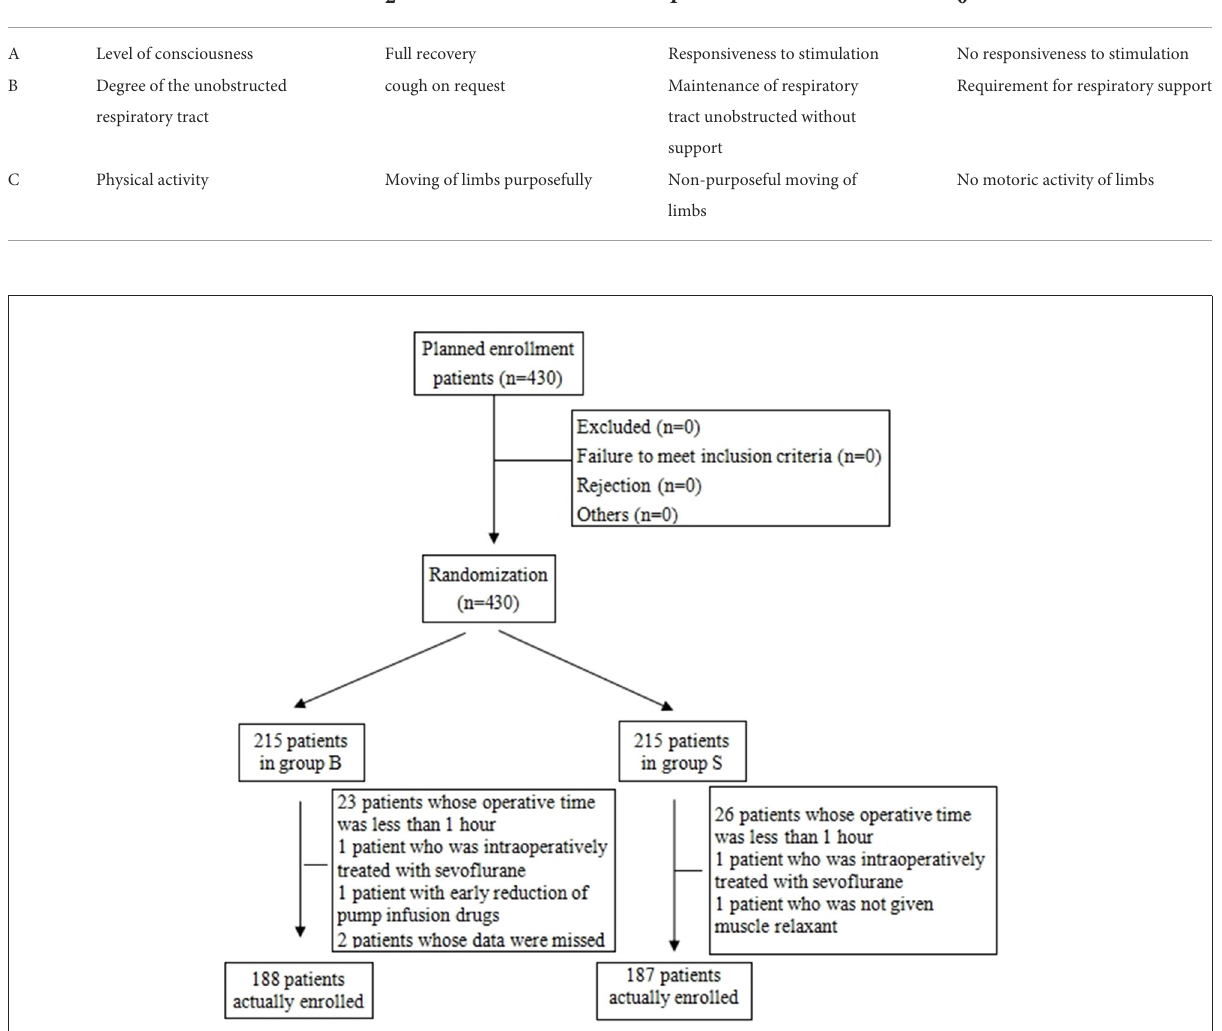
FIGURE1 Flowchart showing the process of enrollment of all